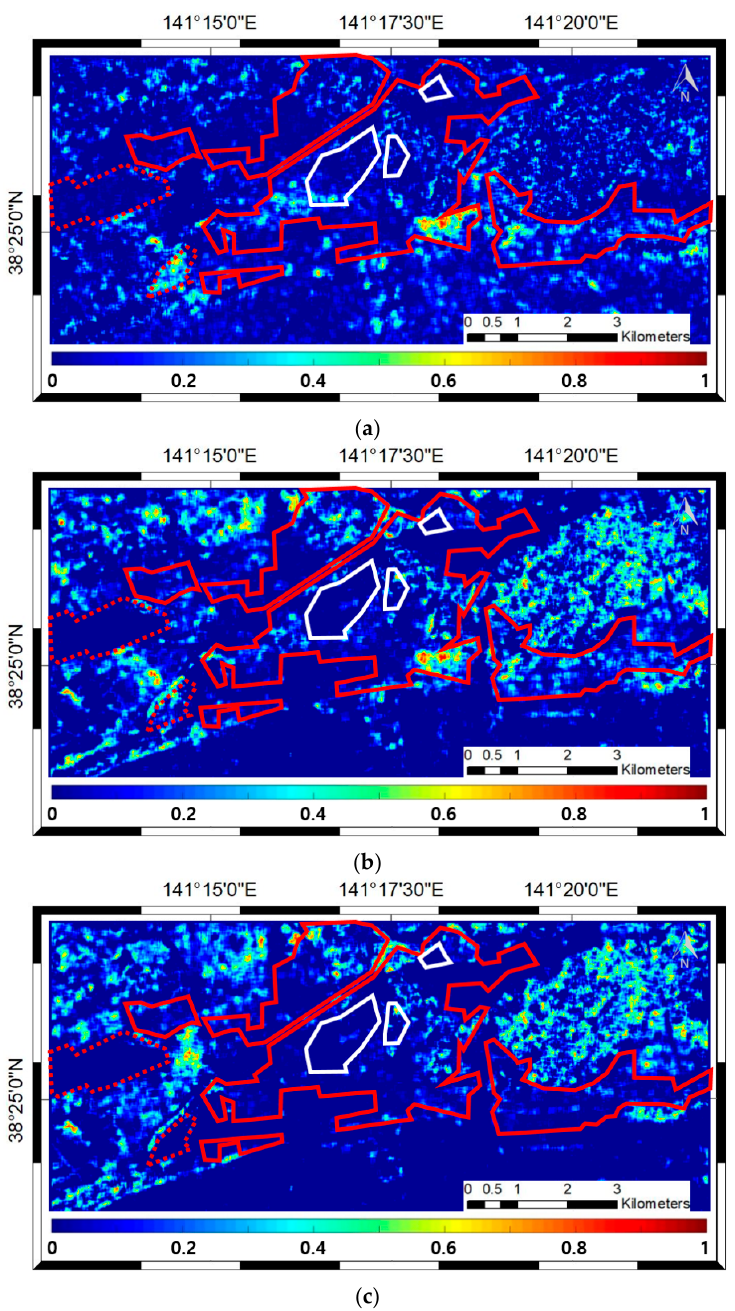
Figure 10. Damage level map by the index D using: ( a ) The pair of pre- and post-tsunami ALOS/PALSAR-1 data (P1); ( b ) the pair of pre-tsunami KOMPSAT-2 data and post-tsunami ALOS/PALSAR-1 data (P2); and ( c ) the pair of pre-tsunami KOMPSAT-2 data and pre-tsunami ALOS/PALSAR-1 data (P3). The index D values range from 0 to 1. The higher the D value is, the higher the damage level is. The built-up areas with high and low density are highlighted with red solid and dotted lines, respectively. The clouds are highlighted with white